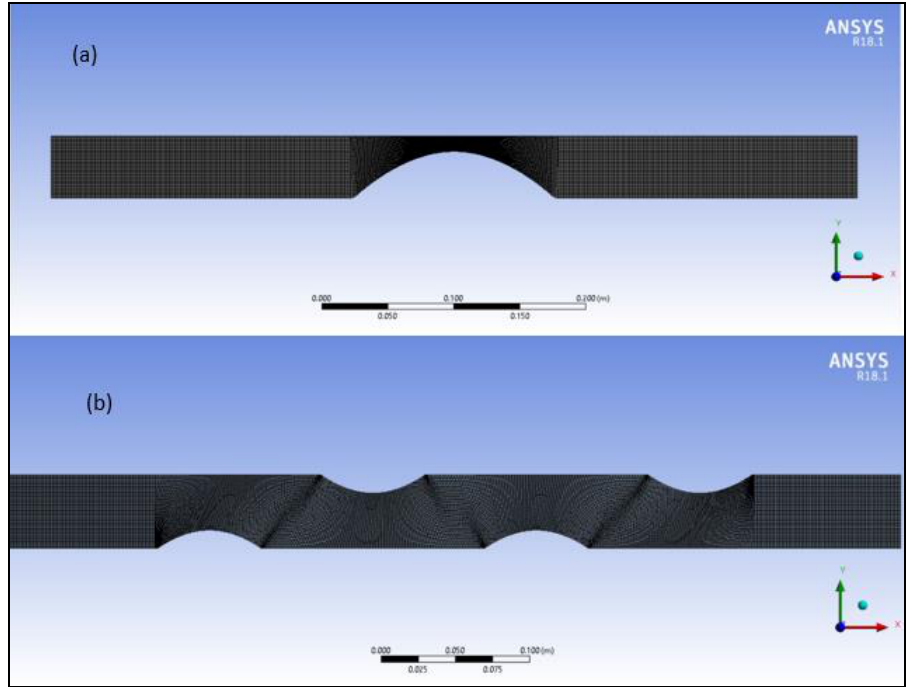
Fig. 2. Meshing (a) Single restriction (b) Multiple